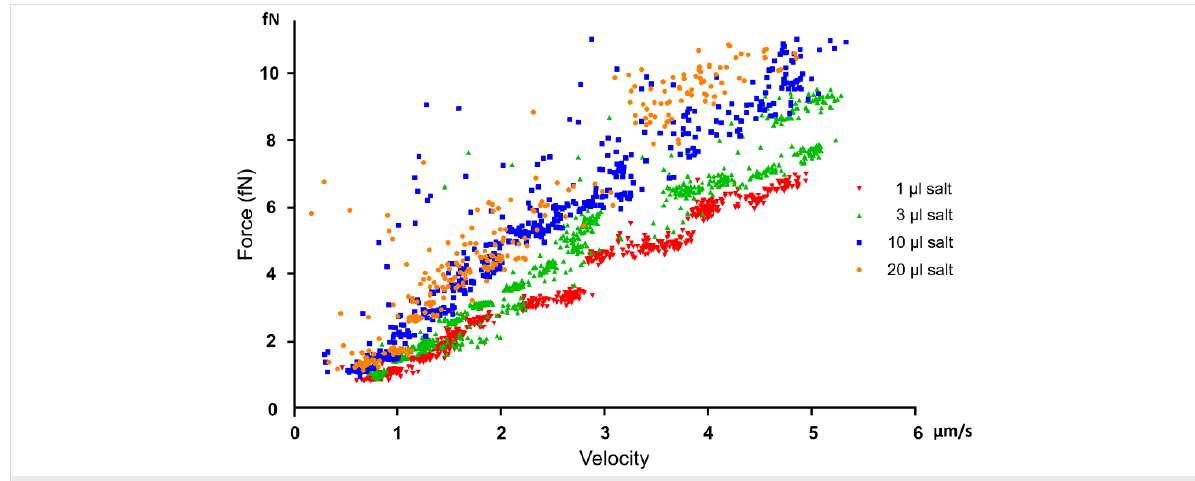
Figure 7: Measured velocity and drag force of the same particle in solution with different salt concentrations. For salt concentrations C1 > C2 > C3 > C4, the relation between particle velocity and measured drag force exhibits the relation as shown in the